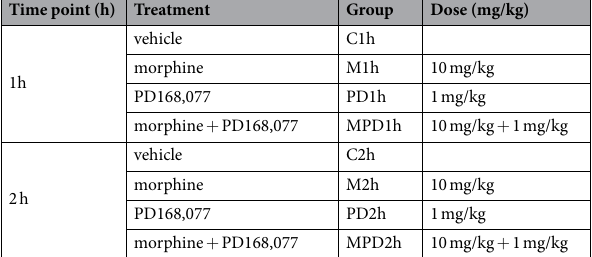
Table 2. Experimental groups of the study. Groups were based on the drug treatment and time of sample extraction (n = 6 per group). RNA from three animals were pooled to perform the analysis (n = 2 pools per experimental